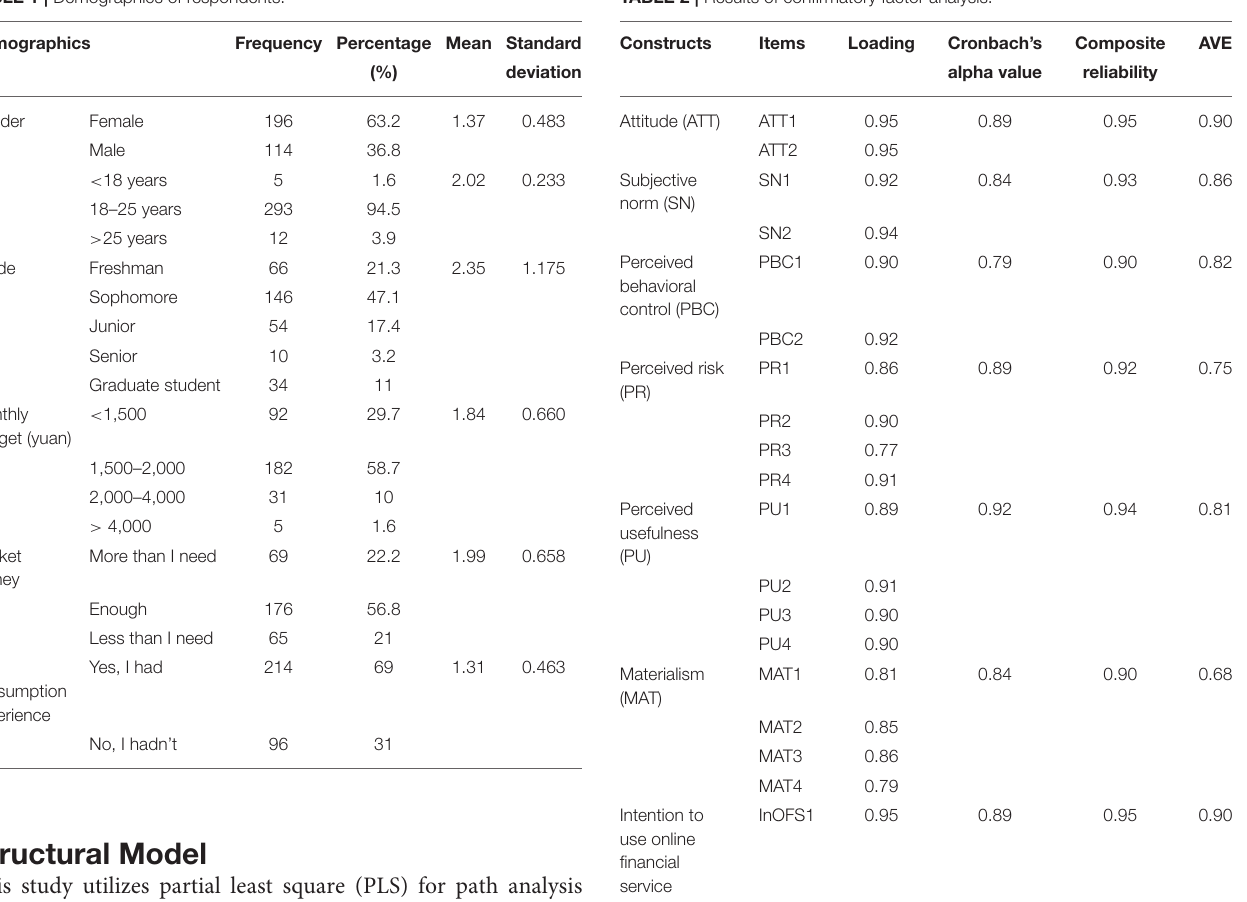
TABLE 1 | Demographics of respondents. TABLE 2 | Results of confirmatory factor analysis.